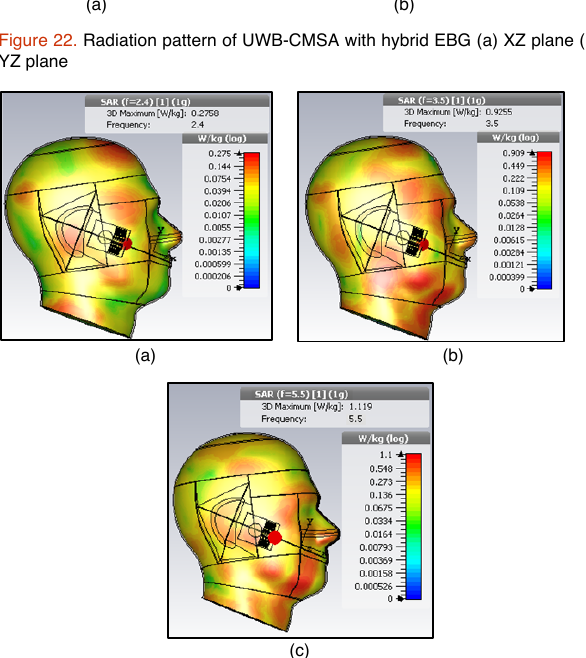
Figure 22. Radiation pattern of UWB-CMSA with hybrid EBG (a) XZ plane (b) YZ plane